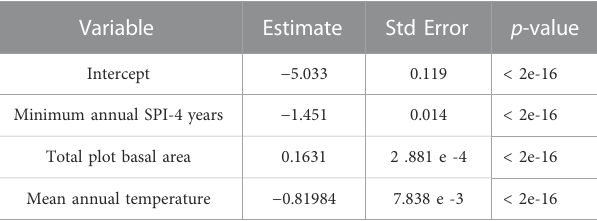
TABLE 1 Generalized linear quasi-binomial model fi t to predict percent ponderosa pine ( Pinus ponderosa ) mortality annually.